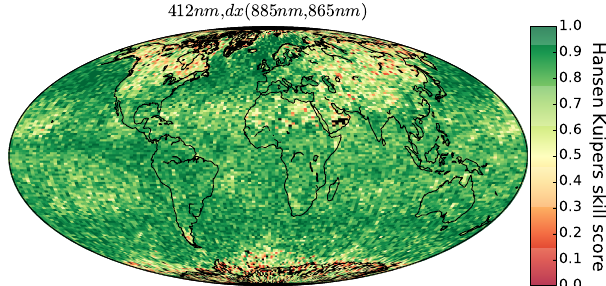
Figure 5. Global distribution of skill scores for a classical Bayesian cloud mask using only two strongly independent features. Data are shown for the year 2008 and the joint probabilities of the mask were estimated with data from the year 2007. The global skill score is 0 . 78 and the used features are shown in the title of the figure.